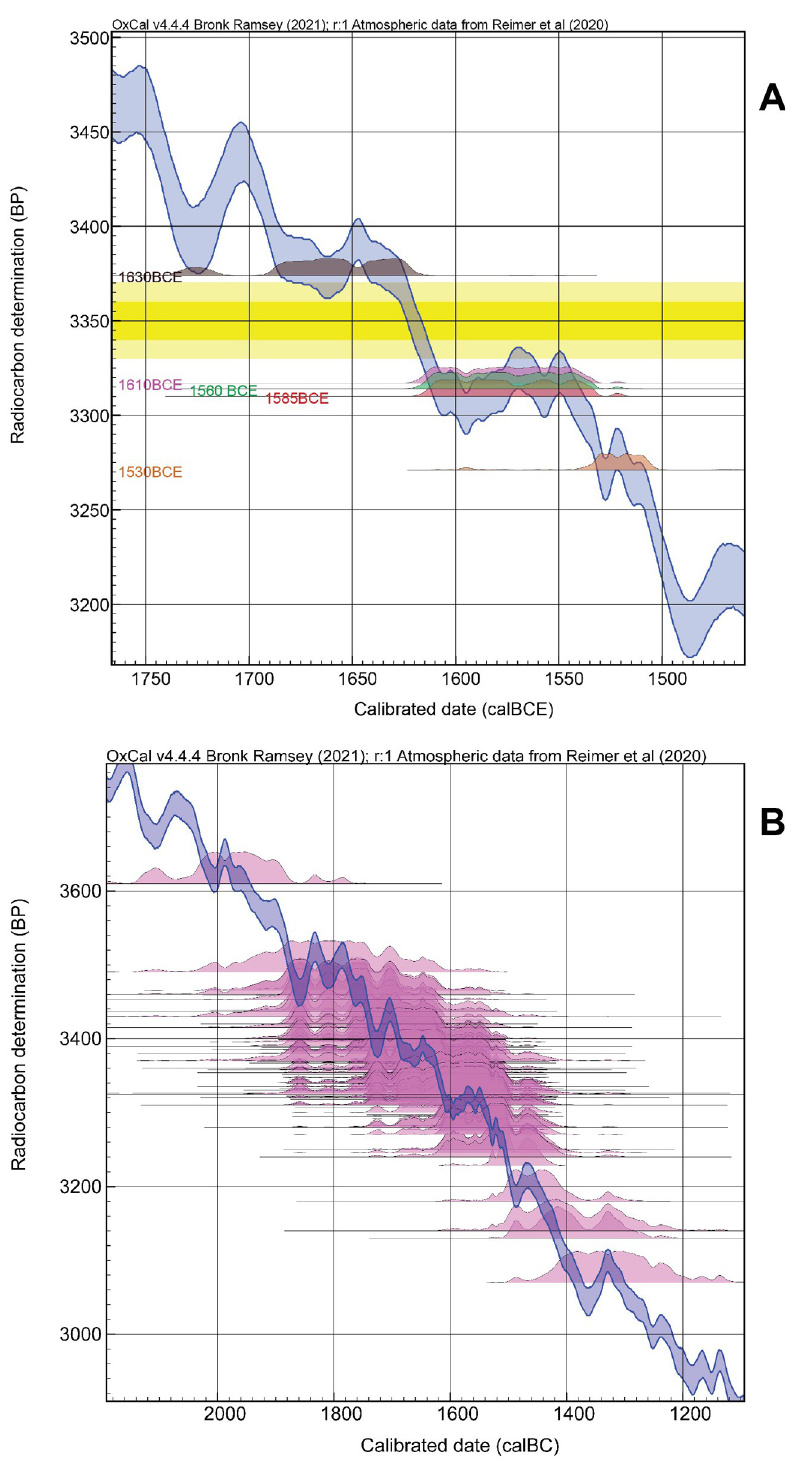
Fig 2. Relationship between 14 C dating of the Thera eruption and IntCal20 14 C calibration curve taphonomy [41]. ( A ) Calibrated calendar age probabilities (no modelling) using OxCal 4.4.4 [57] for 14 C ages drawn from IntCal20 itself for calendar dates 1630, 1610, 1585, 1560, and 1530 BCE illustrate how ages around especially 1610–1530 BCE spread across the reversal-plateau in the calibration curve ~1620–1540 BCE [41] (see Materials and methods below). The only clarity is that ages � 1630 BCE or � 1530 BCE may be distinguished from those in between. A stated average 14 C age for